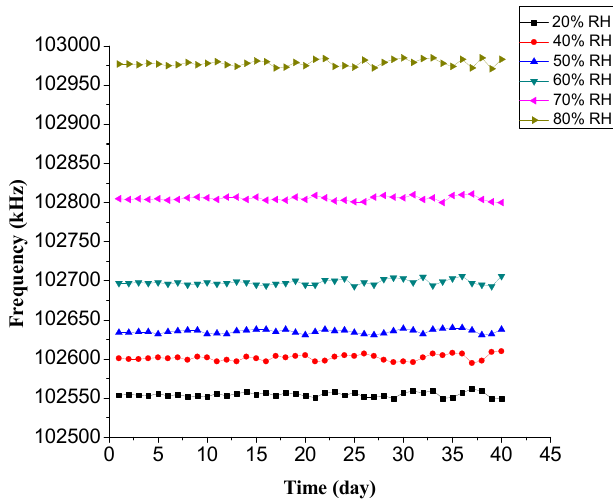
Figure 13. Stability of the Love wave humidity sensor.